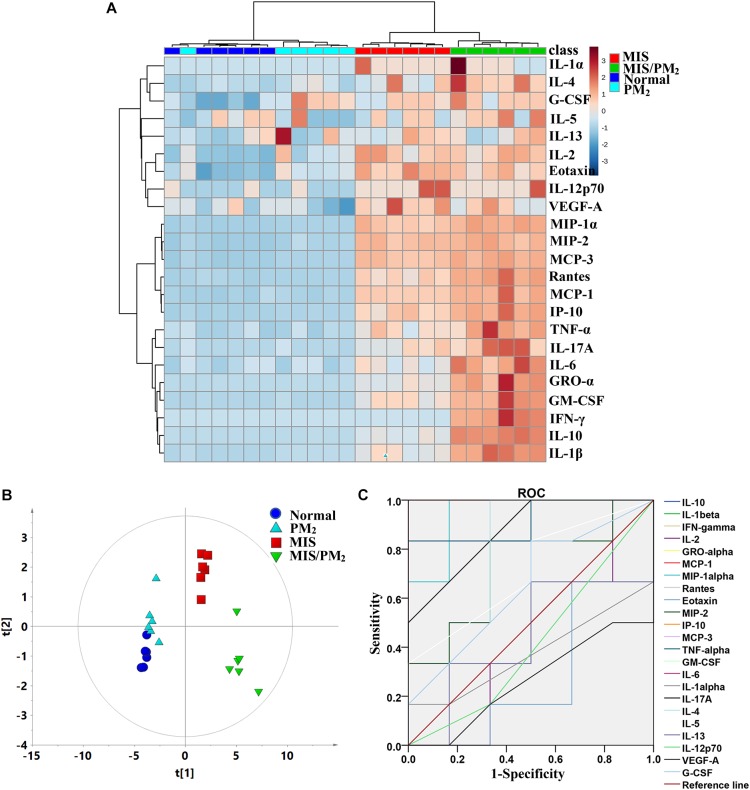
Plasma cytokine expression signatures of PM-IDILI in rats. (A) Clustered heat map analysis of plasma cytokines; the colors represent the contents in each of differentially expressed cytokine; (B) principal component analysis (PCA) of plasma cytokines; (C) receiver operating characteristic (ROC) curves of potential cytokine biomarkers associated with liver injury susceptibility-related factor.